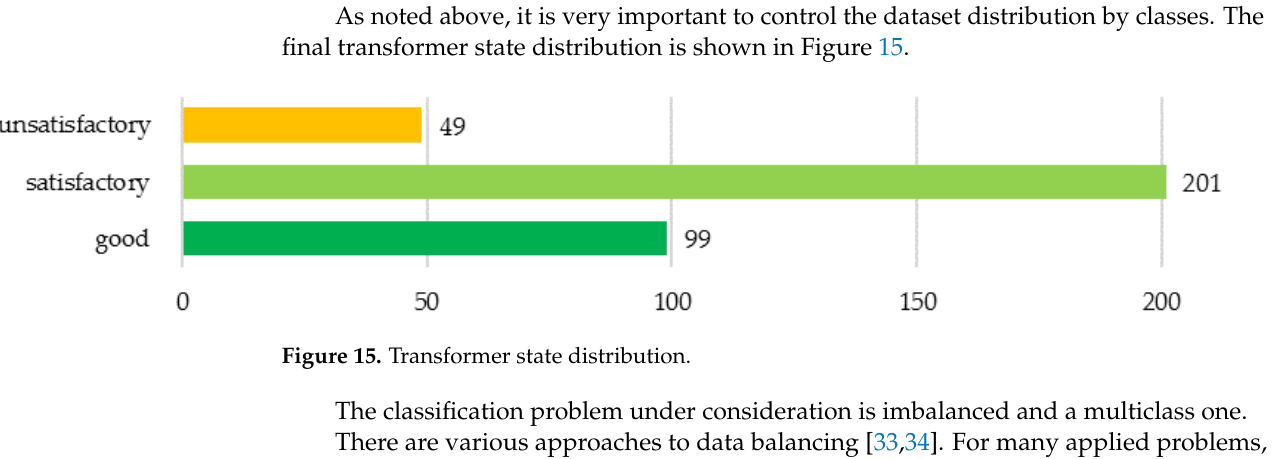
Figure 14. Spearman correlation matrix of the features.